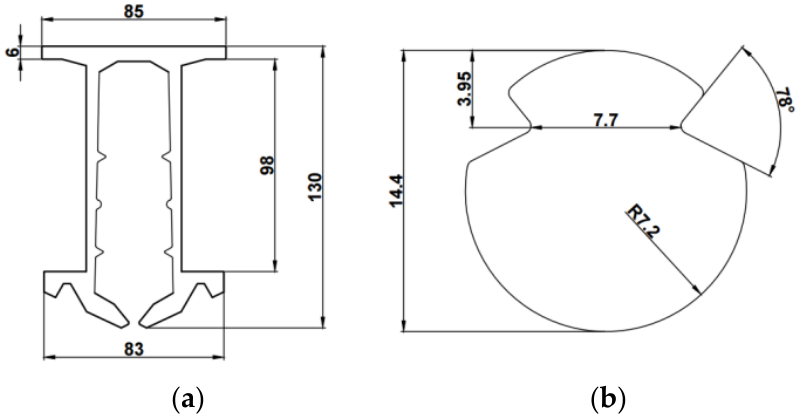
Figure 2. Schematics of conductor rail ( a ) and contact wire ( b ). In Solidworks, the conductor rail and contact wire are modeled according to their realistic geometry (Figure 3). The total length is modeled as 12,000 mm with a span length of 8 m. The material properties, including the conductor rail’s density and elastic modulus, are set to aluminum alloy. According to EN AW 6101B, aluminum accounts for more than 95%, and the material properties are mainly affected by aluminum. The density is 2.7 g/cm 3 , and the elastic modulus is 72 Gpa. The contact wire material is set to copper alloy. The density is 8.9 g/cm 3 , and the modulus of elasticity is 120 Gpa. After loading the model in Anasys, a 4-node planar element, the solid 182 unit is used to mesh the rigid catenary, as shown in Figure 4a. The grid at the conductor rail is evenly divided. The mesh of the contact wire and the connection surface between the contact wire and the clamp is finer to ensure numerical accuracy. For the case of analysis, the total number of elements used to mesh the conductor rail is 1379, and the number of nodes is 1672; the number of 110-height busbar units is 1289, and the number of nodes is 1564. The constraints are applied as demonstrated in Figure 4b, in which the support is added at an interval of 8 m.